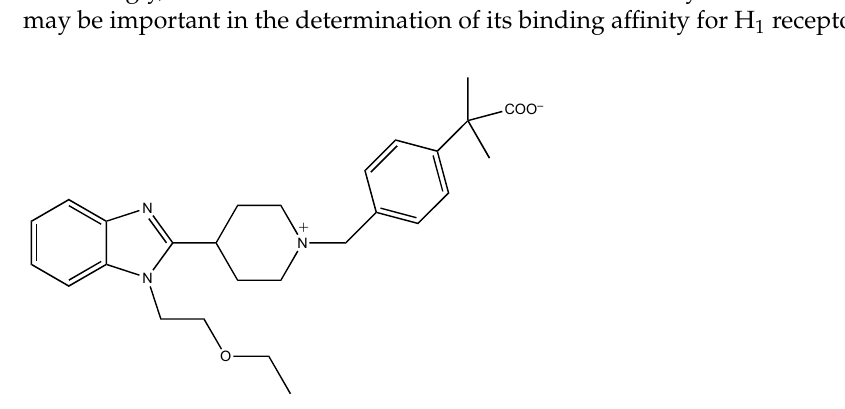
Figure 1. Chemical structure of bilastine. Bilastine is a zwitterionic second-generation antihistamine containing a carboxyl group that contributes to its non-sedative properties as well as an increased selectivity for H 1 receptors.